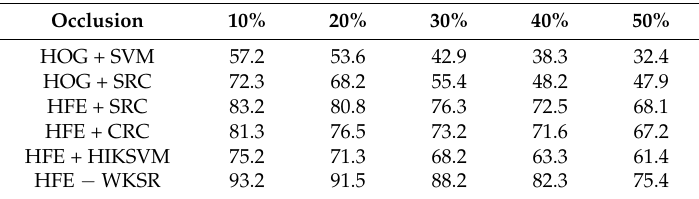
Table 5. Classification results on block occlusion.